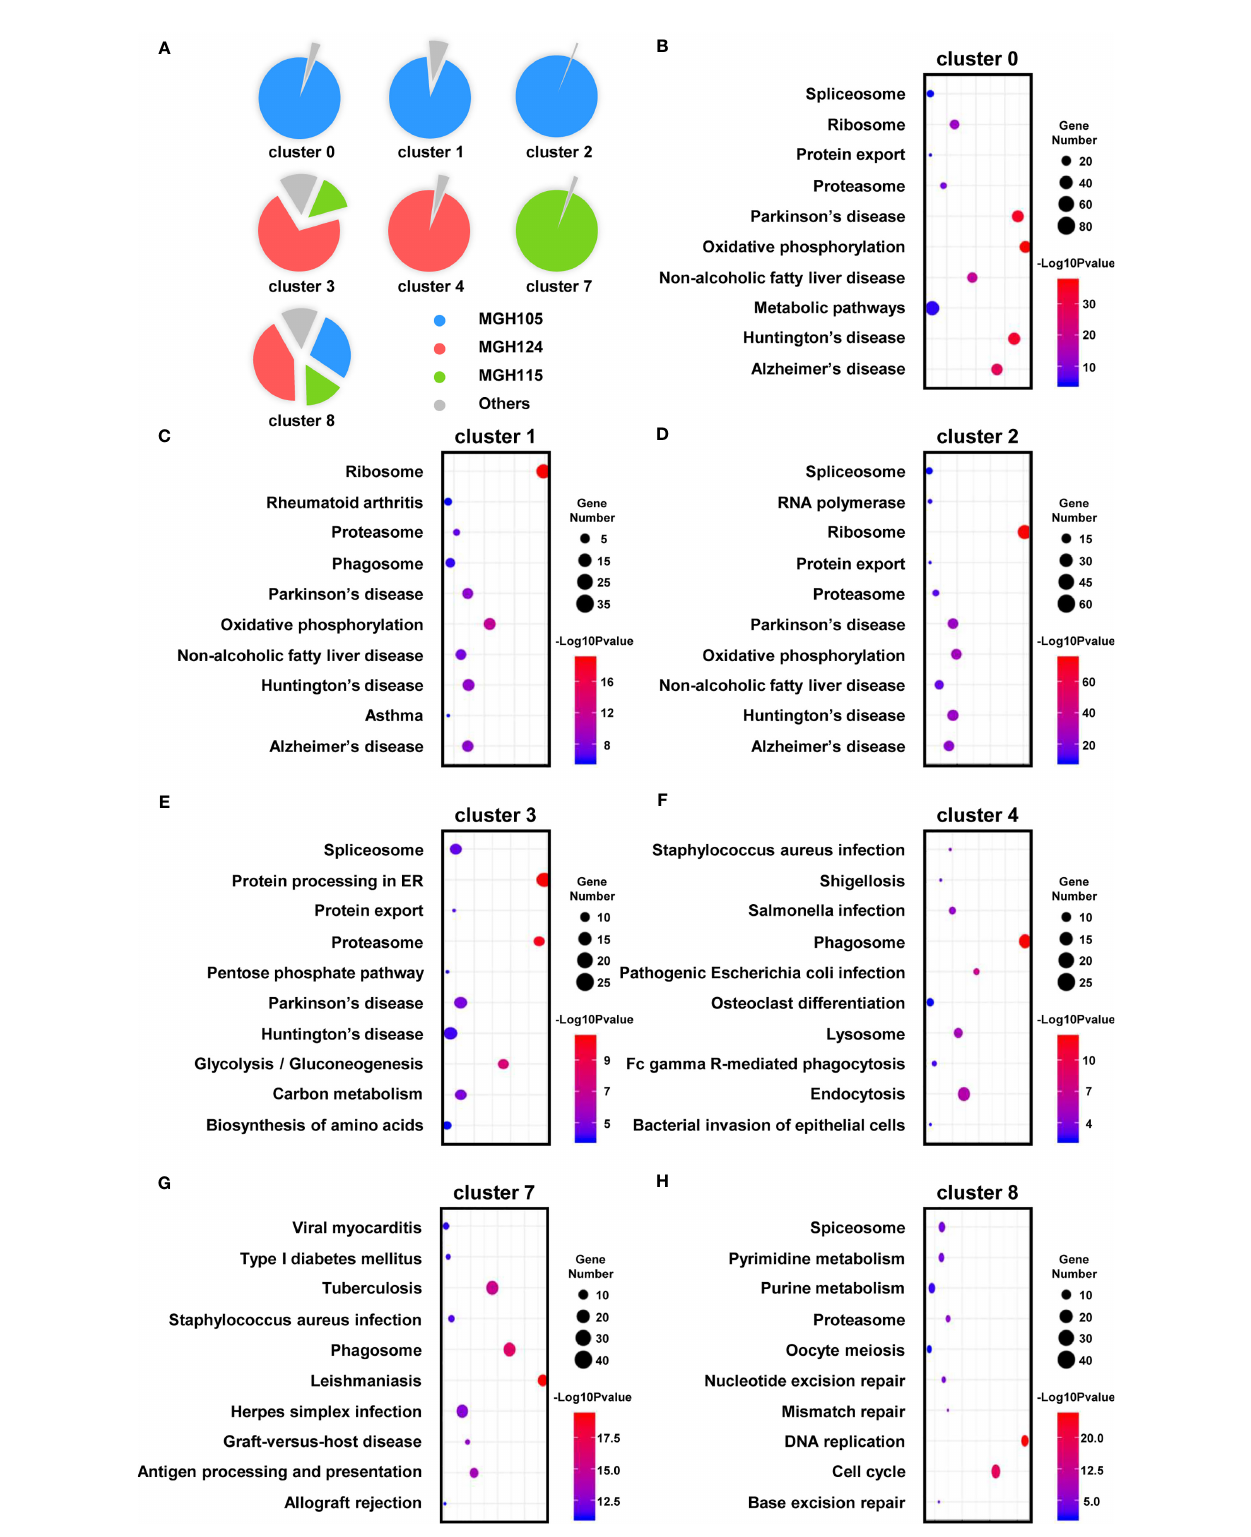
FIGURE 4 | The enriched cellular physiological activities of TAMs differ from each other. (A) Each cluster contains at least three of the nine tissues. (B – H) The enriched KEGG pathways of each cluster are shown in bubble